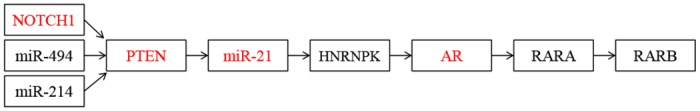
Illustration of clustering of three cascades.The three cascades are almost the same except the beginning elements. We clustered them to provide comparable analysis for detecting disease related cascades.